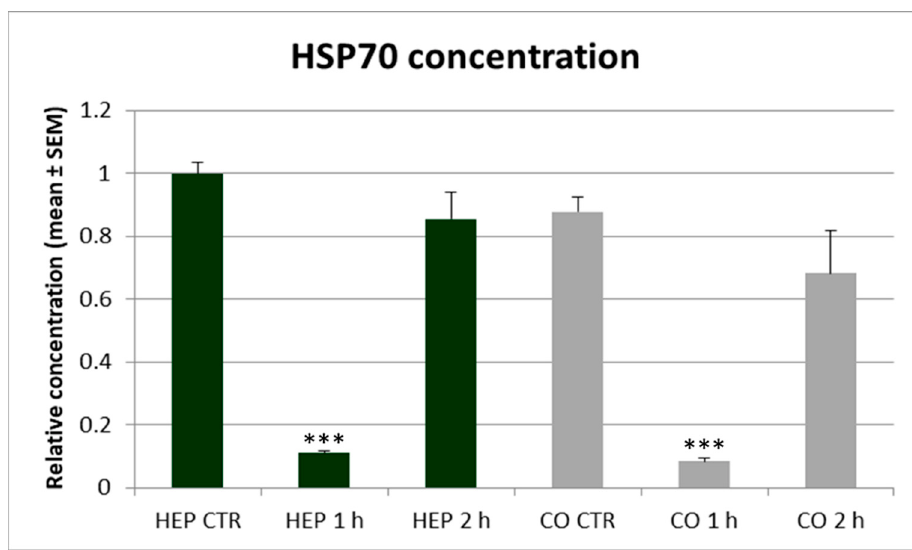
Figure 8. The heat shock protein 70 (HSP70) concentration in culture media of hepatocyte mono-cultures (“HEP”) and hepatocyte—nonparenchymal cell co-cultures (“CO”) as measured by a chicken specific ELISA assay. The “CTR” refers to control cells with no heat exposure, while “1 h” and “2 h” indicate incubation of cell cultures at 43 ◦ C for 1 or 2 h, respectively. Relative concentrations were calculated by considering the mean value of control hepatocyte mono-cultures as 1. Results are expressed as mean ± standard error of the mean (SEM), n = 3 / group. Asterisks over bars of “1 h” and “2 h” refer to significant di ff erences compared to “CTR” cells within the same cell culture model. *** p < 0.001.